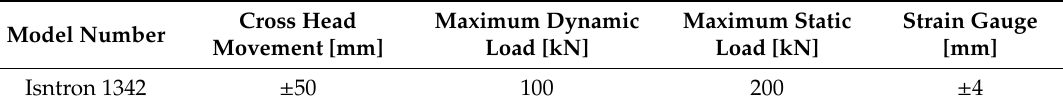
Table 6. Technical characteristics of the test